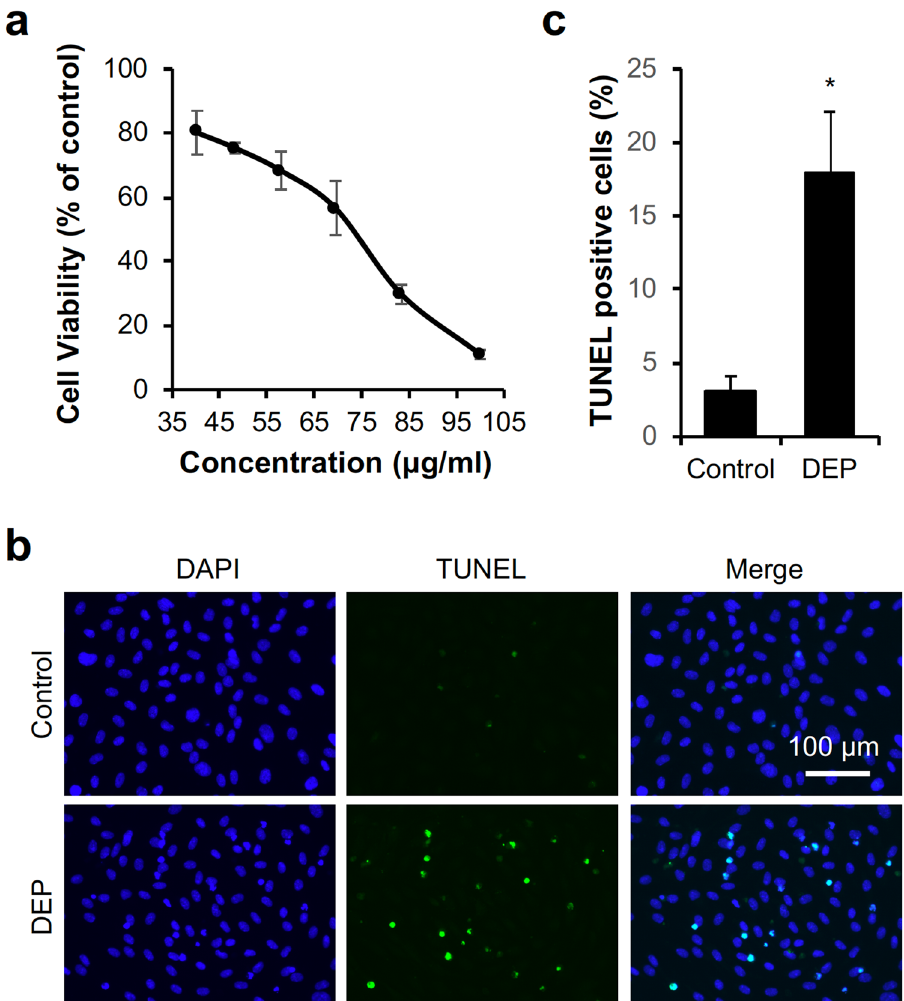
Figure 1. DEP induce HUVECs apoptosis. ( a ) HUVECs were exposed to various DEP concentrations for 24 h and cell viability was measured using a WST-1 assay. ( b ) HUVECs were exposed to the IC 50 DEP concentration (70 µg/ml) for 24 h. Cells were then subjected to TUNEL staining. ( c ) Quantification of TUNEL-positive cells. TUNEL-positive apoptotic cells were counted and expressed as a percentage of total nuclear counts. Results are presented as means ± SD from five randomly selected fields. Statistical analysis was performed using two-tailed Student’s t test. * P < 0.05 versus